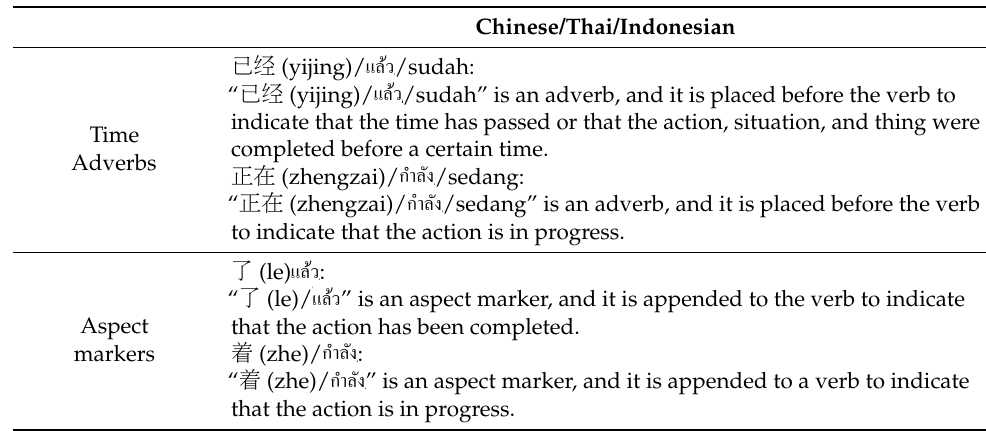
Table 1. Time adverbs (Chinese, Thai, and Indonesian) and aspect markers (Chinese and Thai). Chinese/Thai/Indonesian